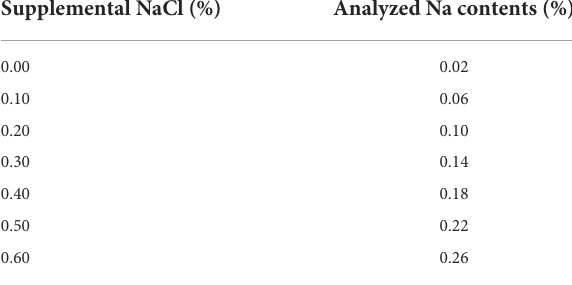
TABLE 2 Analyzed Na concentrations in diets for broilers from 1 to 21 days of age a